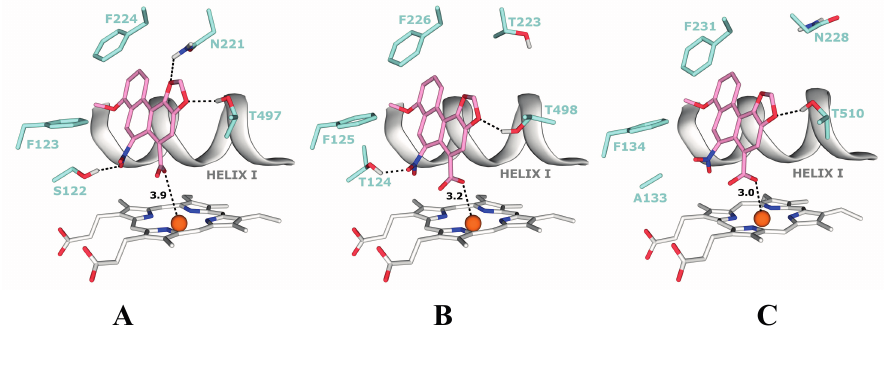
Figure 7. The most favorable binding orientations of AAI docked into the active site of CYP1A1 ( A ), 1A2 ( B ) and 1B1 ( C ). Hydrogen bonds between AAI and the amino acid residues in active site residues are rendered as dashed black lines. AAI (pink), heme (grey) and side chains of important amino acid residues (cyan) are rendered as bold sticks; iron ions as orange